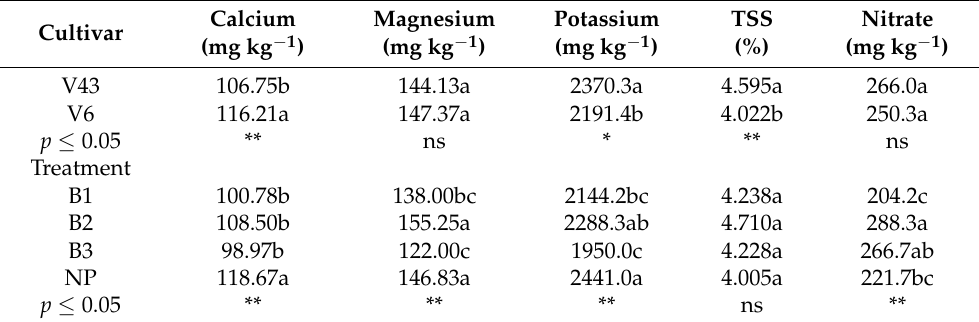
Table 4. Fruit mineral and nitrate contents of tunnel-grown cayenne pepper cultivars in response to PGPR and chili residue